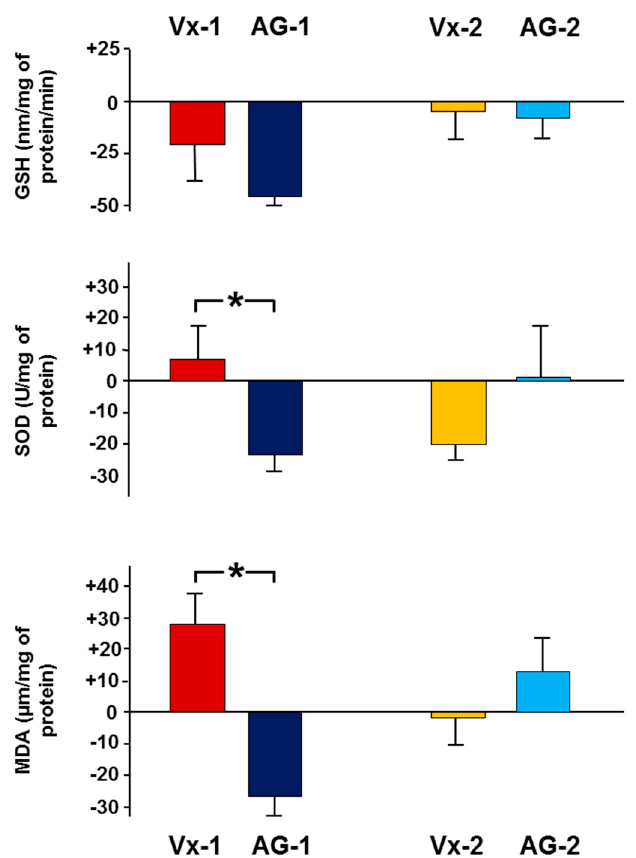
Figure 2. The percentage difference in the tissue concentration of malonedialdehyde (MDA), reduced glutathione (GSH), and superoxide dismutase (SOD) between the left and right kidneys in all groups. Values represent mean ± SEM. * indicates statistical significance between corresponding groups.